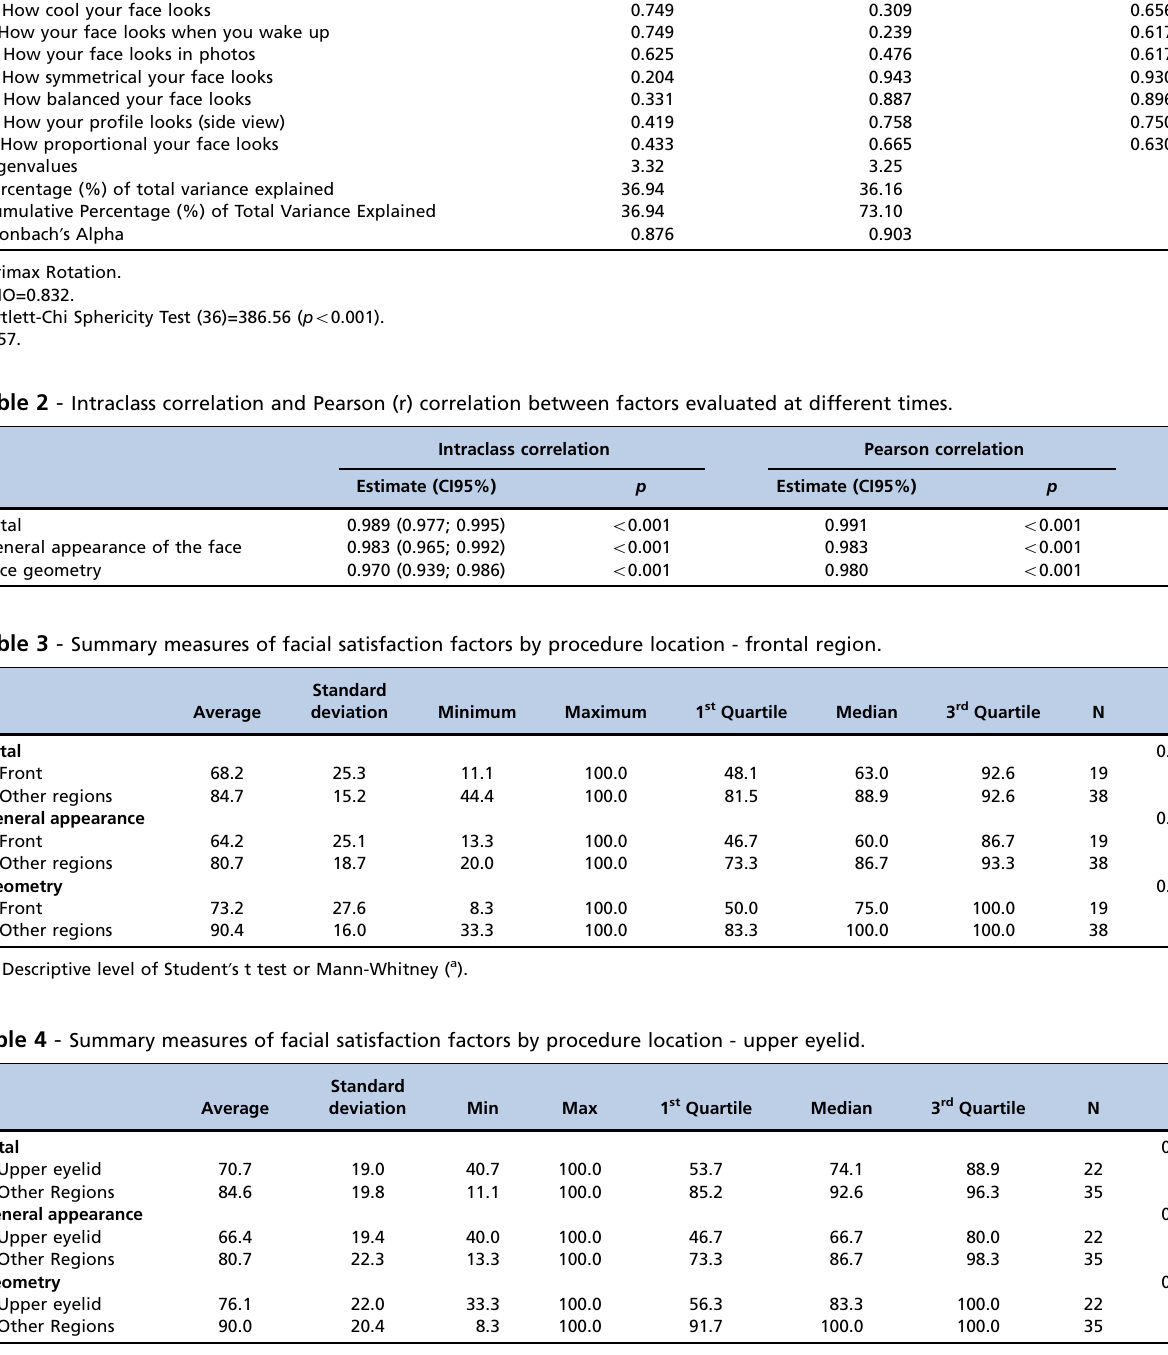
Table 1 - Factorial loads, eigenvalues, percentage of explained variance and Cronbach ’ s alpha coefficient of the two factors of the Face-Q SFAOS. Factors